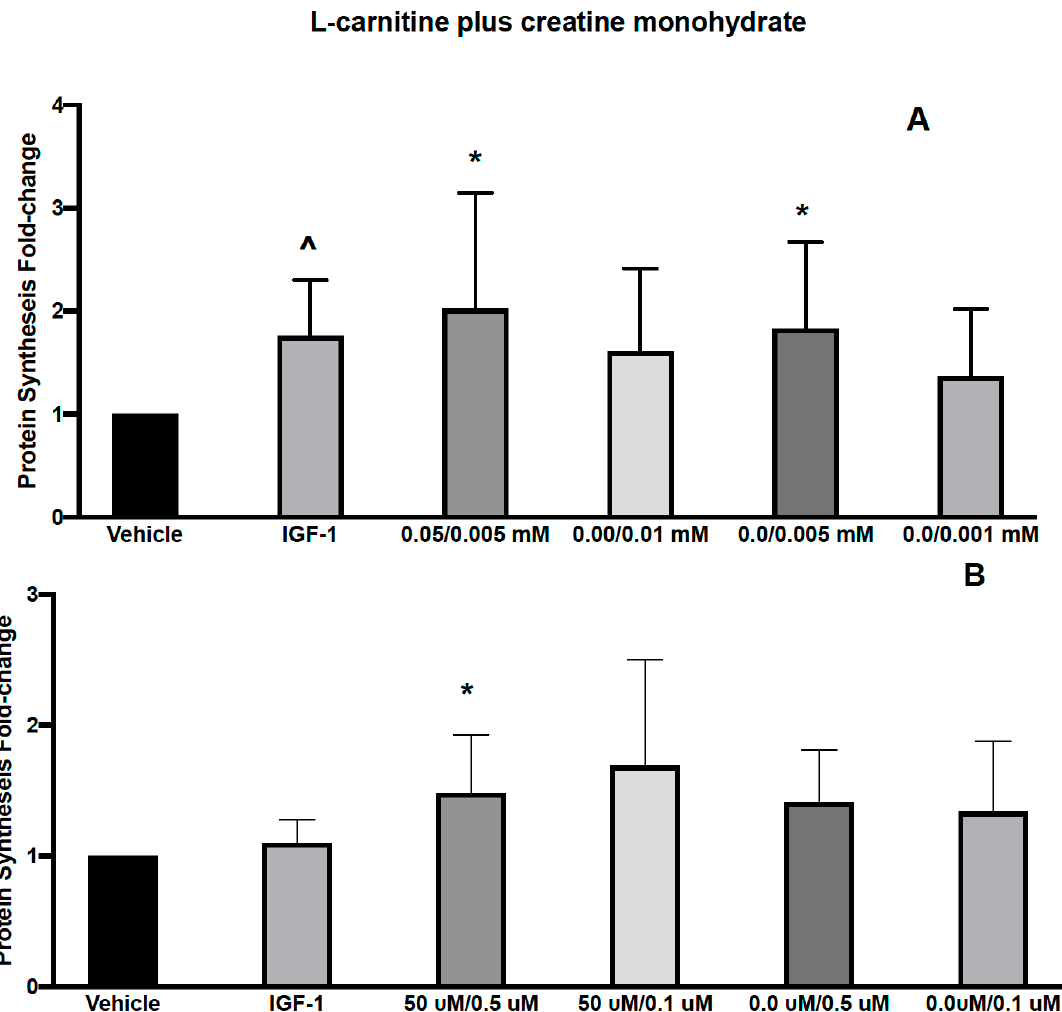
Figure 2. Effects of L-carnitine and creatine at 0.05/0.005 mM and creatine at 0.01, 0.005 and 0.001 mM on muscle protein synthesis ( A ). IGF-1 used as a positive control increased protein synthesis by 1.76 ± 0.22 and L-carnitine/Creatine at 0.05/0.005, 0/0.01, 0/0.005 and 0/0.001 mM by 2.02 ± 0.46, 1.61 ± 0.33, 1.83 ± 0.34 and 1.37 ± 0.27, respectively from vehicle control. Effects of L-carnitine and creatine at 50 µ M/0.5 µ M and 50 µ M/0.1 µ M and creatine at 0.5, 0.1 µ M were assessed for their effects on muscle protein synthesis ( B ). IGF-1 used as a positive control increased protein synthesis by 1.1 ± 0.07 and L-carnitine/Creatine at 50/0.5, 50/0.1, 0/0.5, 0/0.1 mM by 1.48 ± 0.17, 1.69 ± 0.29, 1.41 ± 0.15 and 1.34 ± Table 1. phospho-AKT and RPS6 expression in response to varying doses of L-carnitine (CARN) and creatine (Cr). IGF-1 is positive control.